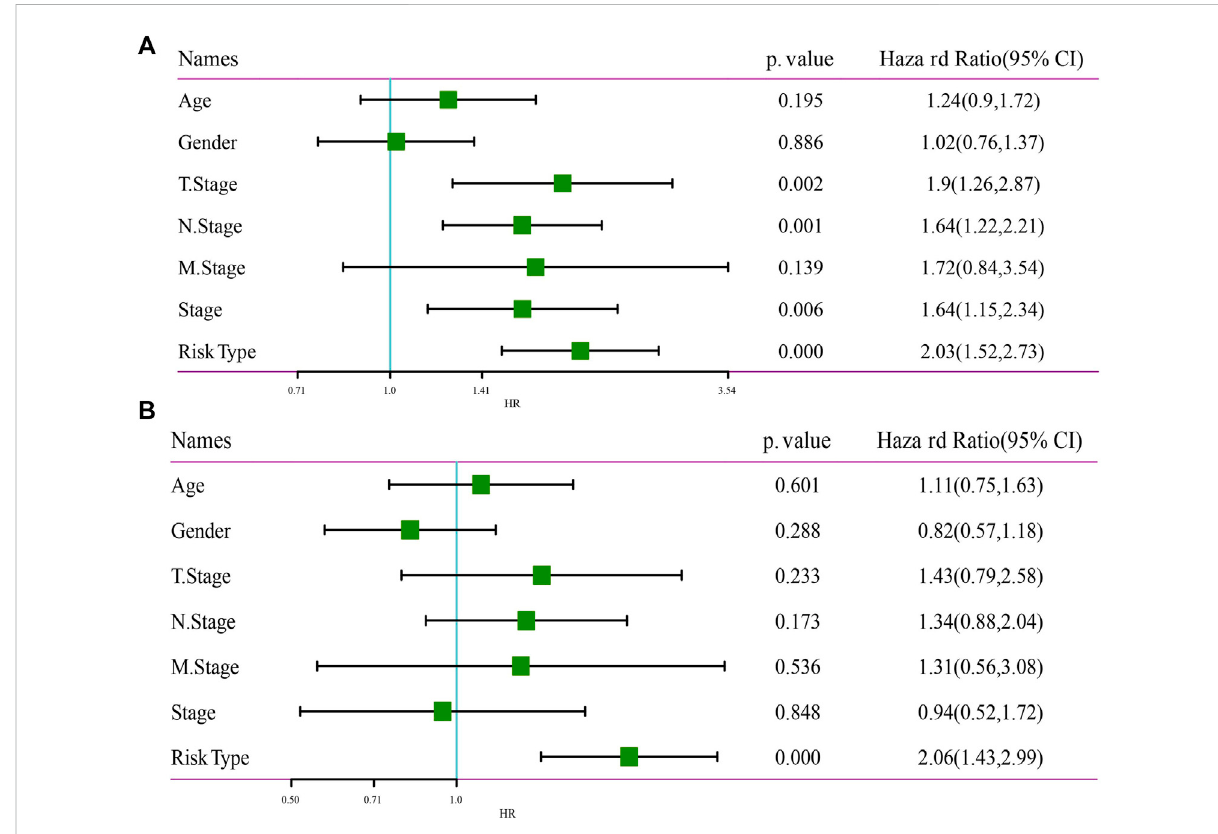
FIGURE 10 Independence of RiskScore. (A) Univariate Cox regression analysis. (B) Multivariate Cox regression